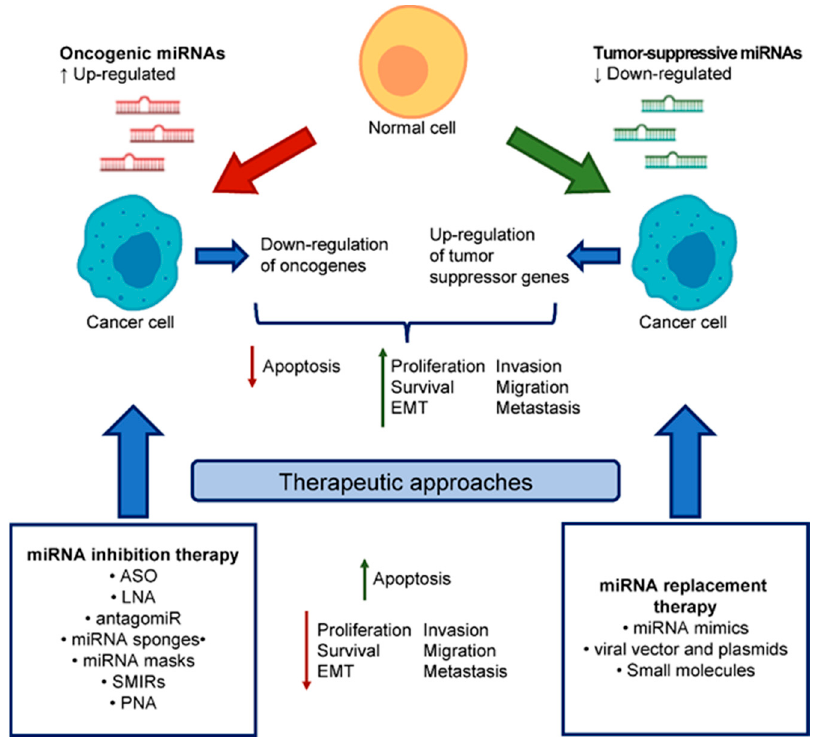
Figure 2. Role of miRNAs in cancer and approaches for miRNA-based therapies. Aberrant miRNAs expression is a common finding in cancer. Upregulation of oncogenic miRNAs determines a general downregulation of their tumor suppressor gene targets, while the downregulation of tumor- suppressive miRNAs induces the upregulation of the target oncogenes, altogether supporting the cancerous cell to block apoptosis and promote proliferation, EMT, invasion, migration and metastasis. Therapeutic approaches targeting miRNAs may consist of two strategies. The miRNA inhibition therapy is based on the use of different types of miRNA inhibitors to target upregulated oncogenic miRNAs, leading to the consequent upregulation of tumor suppressor genes. The miRNA replacement therapy, on the other hand, is based on the reintroduction of the downregulated tumor- suppressive miRNA function for the consequent downregulation of the target oncogenes. The effects of miRNA-based therapies contribute to promote an increase in cell death and counteraction of tumor development, eventually leading to the restoration of a more physiological phenotype of the malignant cell. 4.1. MiRNA Replacement Therapy Tumor-suppressive miRNAs are usually downregulated in cancer cells, consequently leading to the upregulation of the target oncogenes and the promotion of tumorigenesis. miRNA replacement therapy consists of the reintroduction of the tumor-suppressive miRNA to restore the lost function. In this aim, several agents can be used: e.g., small molecules, miRNA mimics, and DNA plasmids encoding a miRNA gene that alters epigenetically the endogenous expression of the miRNA [127]. Small molecules, used for the restoration of miRNA function, consists of hypomethylating agents or enoxacin that induce miRNA expression in a non-specific manner by enhancing miRNA synthesis and processing [126,128]. miRNA mimics, on the other hand, are far more used and studied. They are small synthetic RNA duplexes, usually chemically modified, bearing the same sequence of the tumor-suppressive miRNA, that are loaded into the RISC complex and processed to promote the downstream inhibition of the mRNA target [126]. Restoration of gene function is commonly used in gene therapy, where a protein- encoding gene needs to be reinserted in the target cells. For this purpose, usually DNA plasmids or